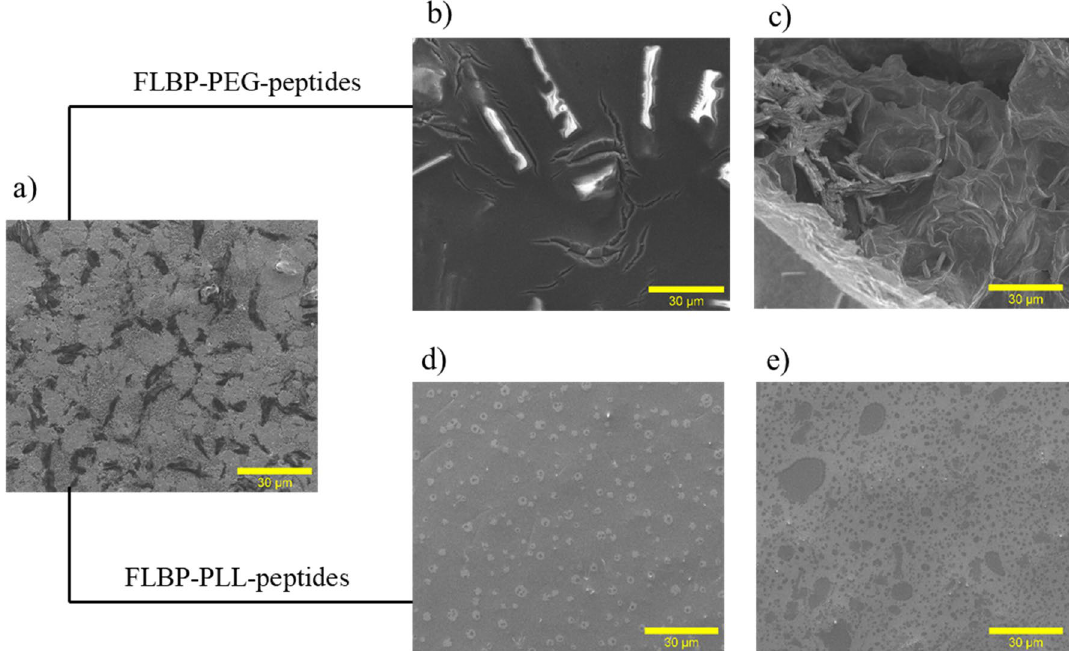
Figure 9. Scanning electron microscopy before and after functionalisation of FLBP: ( a ) FLBP, ( b ) FLBP-PEG- KRK, ( c ) FLBP-PEG-RGD, ( d ) FLBP-PLL-KRK, ( e ) FLBP-PLL-RGD.